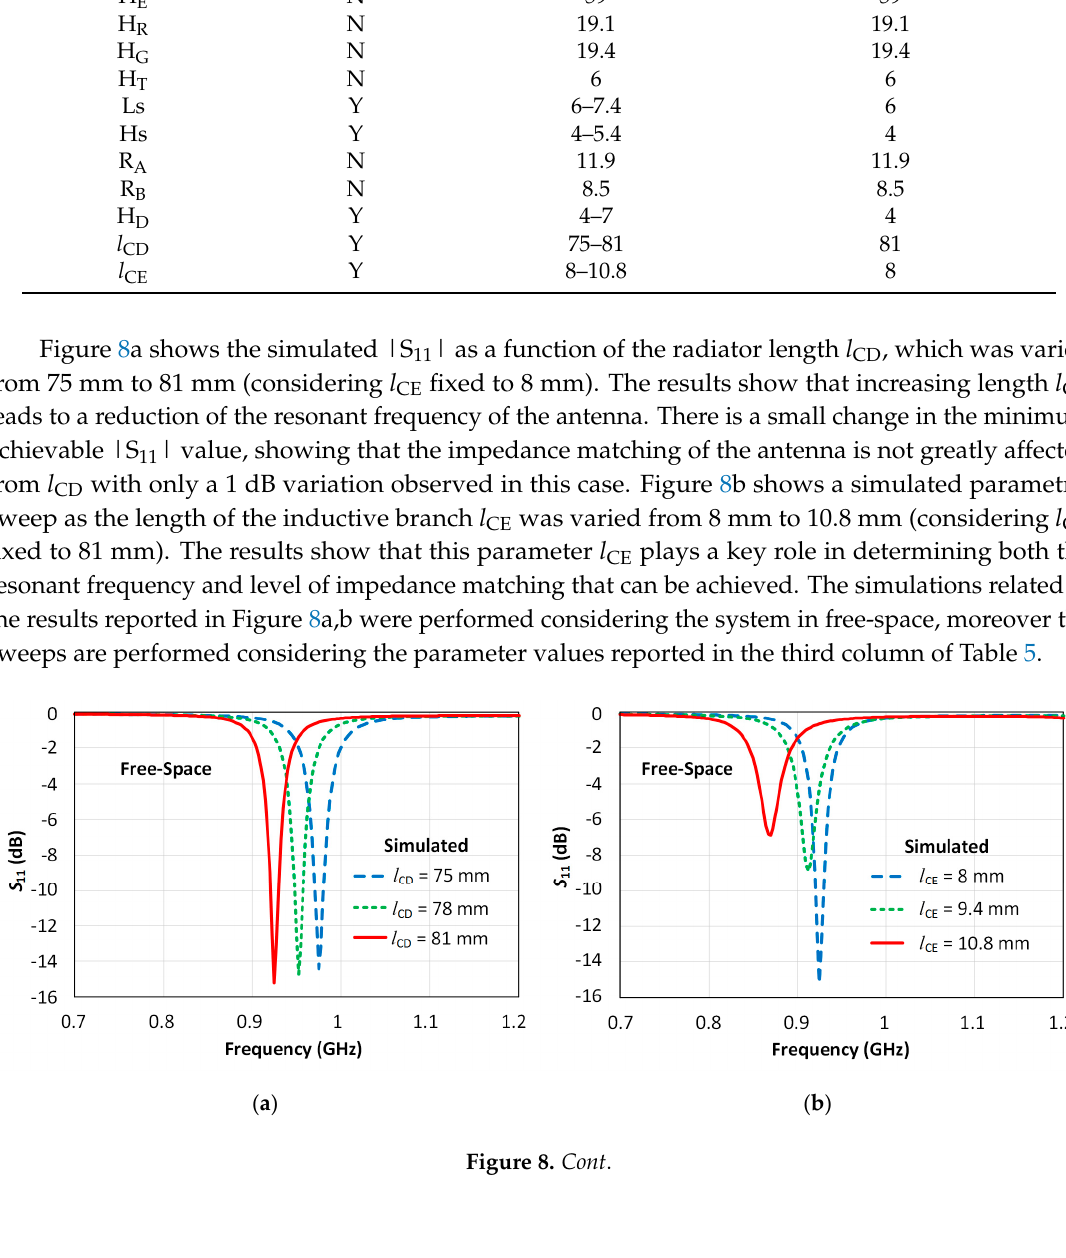
Table 5. Tabulated values of the antenna physical parameters (free-space).